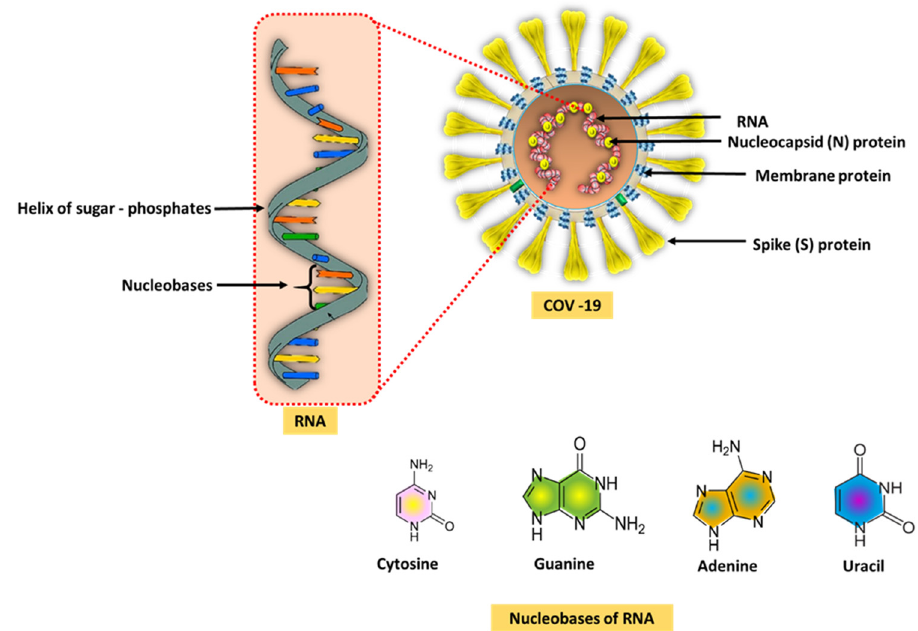
Figure 2: COVID - 19 RNA structure [ 16 ]